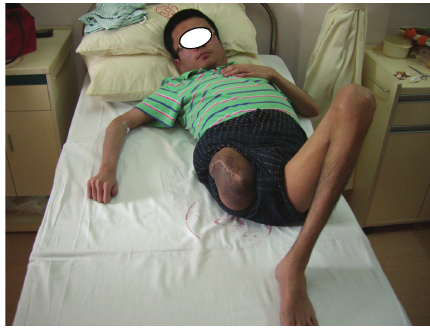
Figure 5: Ten months after operation patient’s overall health condition improved